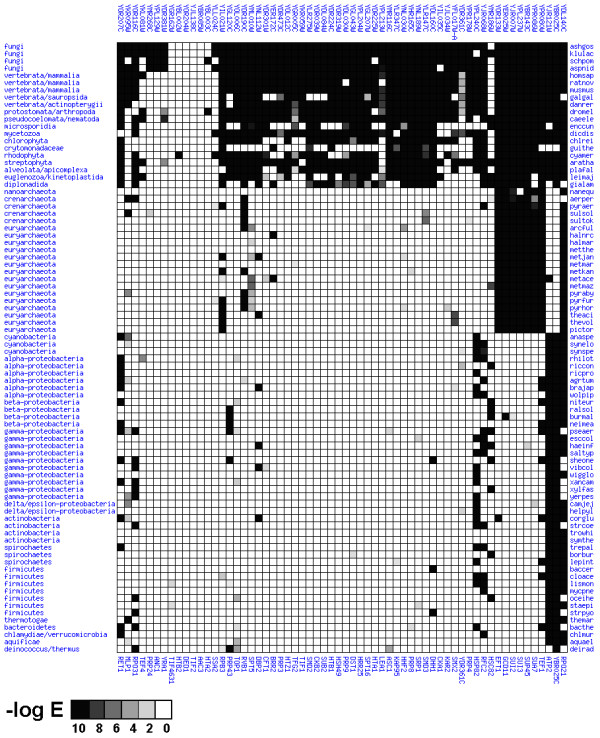
Phylogenetic profiling of novel nucleolar/ribosome-associated proteins. Phylogenetic profiles of 62 previously unrecovered nucleolar/ribosome-associated proteins of yeast across 84 organisms. The profiles were generated using the best reciprocal hit method with yeast as a reference organism (see Materials and methods). Abbreviations given on the top of the plot represent organism names (first three letters for genus and first three letters of species names; see Materials and methods for a translation of abbreviations into organism names). Further taxonomic annotation is given on the bottom of the plot. Yeast open reading frame identifiers are given on the left side, and gene names and descriptions are given on the right side of the plot. The significance of sequence similarity is visualized by different shades of gray that reflect the logarithmic expectation (E) value from reciprocal BLAST searches (shown at the bottom of the figure). Here, the E values of BLAST searches using target proteome sequences as queries versus the yeast proteome reference database are shown. The genes are ordered according to hierarchical clustering (see Materials and methods).